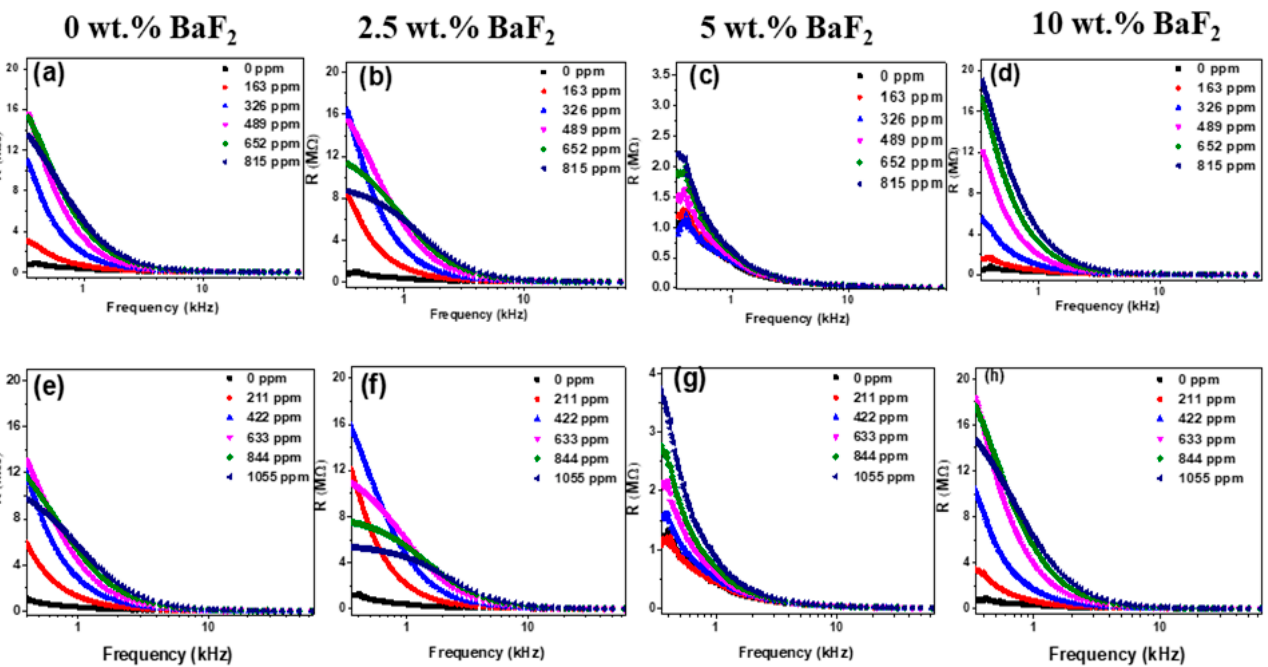
Figure 3. Dependence of sensor resistance on frequency with increasing concentrations of ( a – d ) acetone and ( e – h ) ethanol vapours. Table 1. Optimum frequency ( f ), determined limit of detection concentration (LoD), and sensitivity ( S ) for detection of acetone, ethanol, and acetone: ethanol